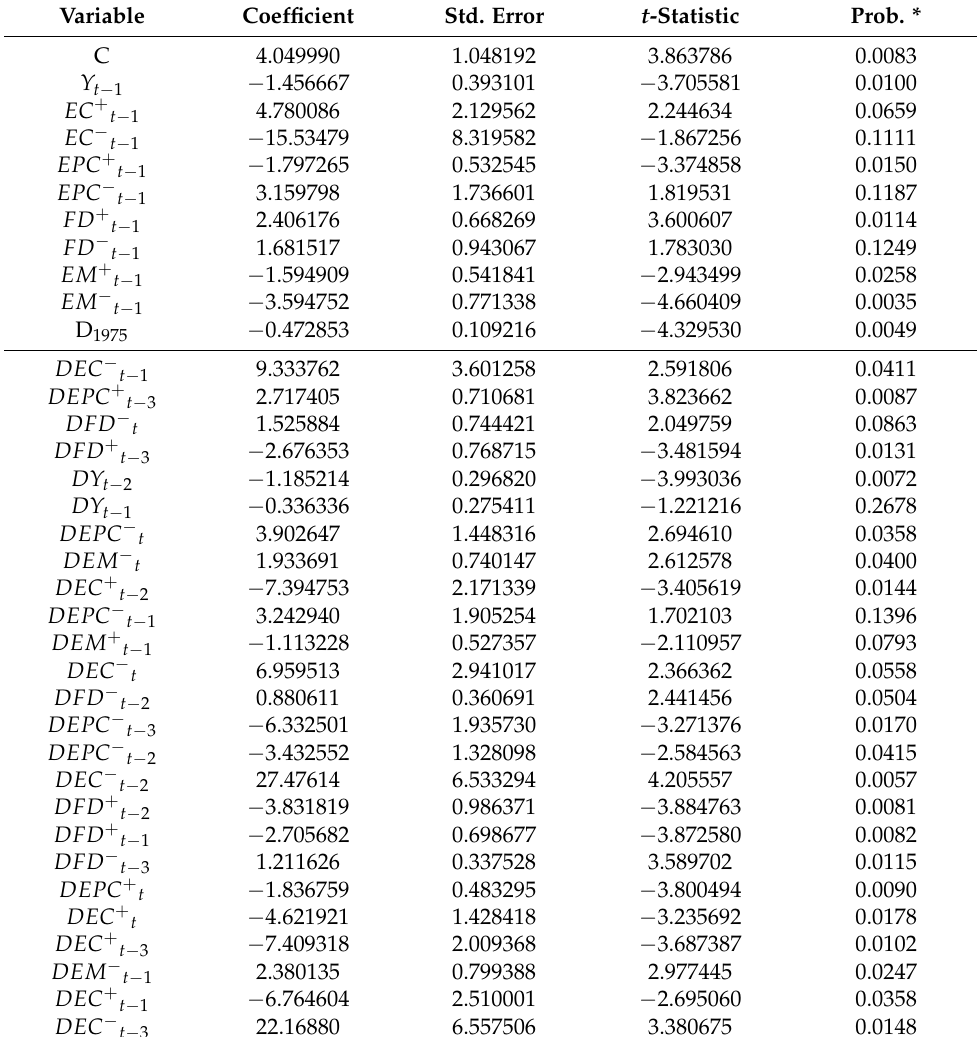
Table 6. Co-integration